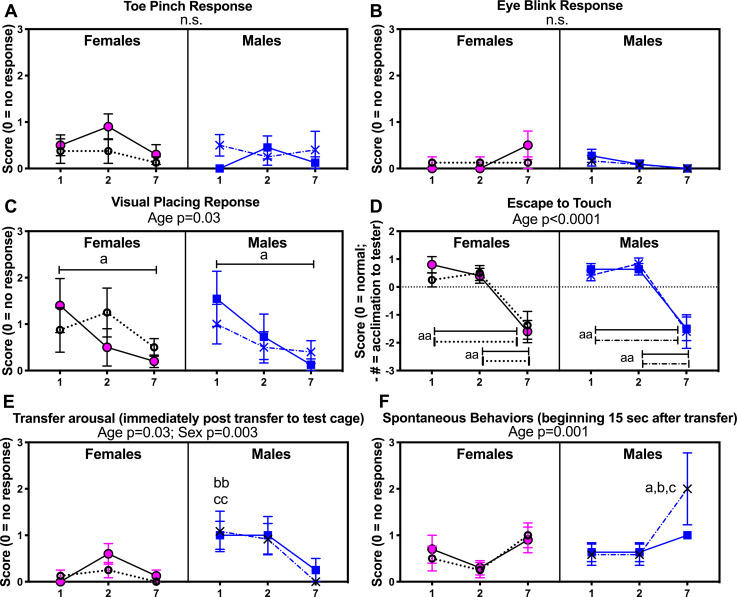
Neurological reflexive testing.Select neural reflexive results from the general neurological health screenings, in wild-type mice -/- and heterozygous Tg26 +/- mice of both sexes, across time (1, 2 and 7 months of age). (A) Responses to toe pinch. (B) Eye blink response (tester approaches mouse’s eyes with a sterile cotton swab). (C) Responses to a visual placing test. (D) Escape to touch (tester approaches mouse with tester’s index finger). (E) Transfer arousal immediately after transfer to the test cage, with higher number indicating higher arousal behaviors. (F) Spontaneous behaviors (beginning 15 sec after transfer), with high number indicating more vigorous/excitable behaviors. Mean ± SEM shown. Not significant (n.s.); a and aa: p<0.05 and p<0.01, compared to values obtained for these same animals at 1 mo; b: p<0.05 and bb: p<0.01, compared to opposite sex of same genotype; c:p<0.05 and cc: p<0.01, compared to opposite sex of opposite genotype. Numbers/group: At 1 and 2 months of age, there were 10 female wild type -/- mice, 8 female Tg26 +/- mice, 10 male wild type -/- and 10 male Tg26 +/- mice. At 7 months of age, there were 10 female wild type -/- mice, 8 female Tg26 +/- mice, 8 male wild type -/- and 5 male Tg26 +/- mice.